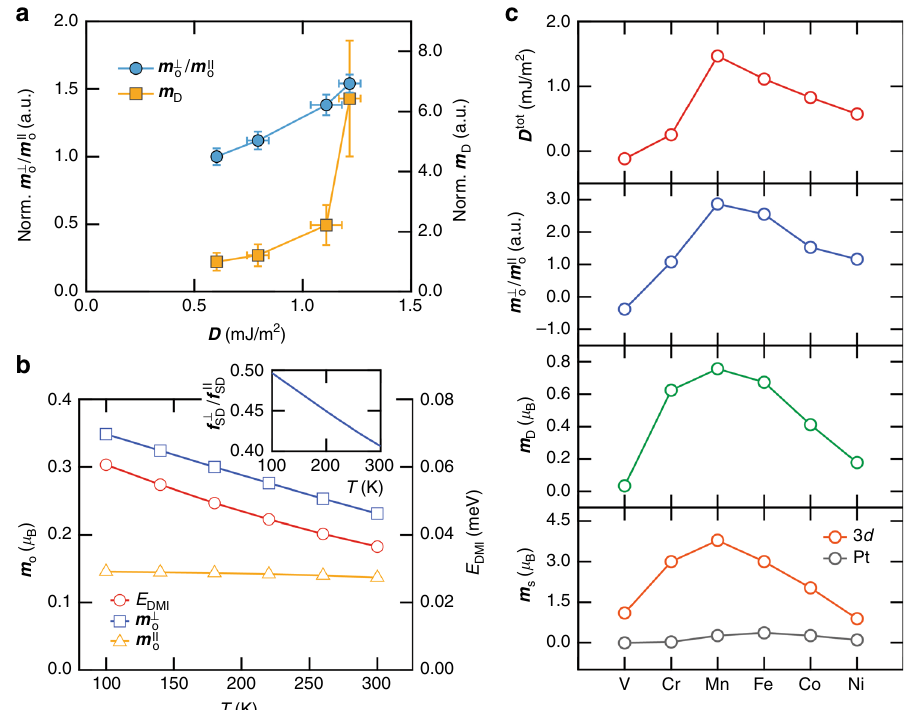
= m k and m D , and theoretical calculations based on the tight binding model and DFT. a Normalized m ? Fig. 5 Correlation of DMI with m ? o o = m k Values of m ? and m D for all temperatures are normalized by the values measured at 300 K. b Calculated m ? o o binding model as a function of temperature. Inset shows f ? / f k as a function of temperature. c Physical parameters such as total D ( D tot ), m ? SD SD m D tot are calculated around their magnetic ground state using the combination of the relativistic effect s obtained by DFT calculation. Strength and sign of spin – orbit coupling with the spin spirals. A positive sign of D tot indicates a left-rotational sense or left chirality